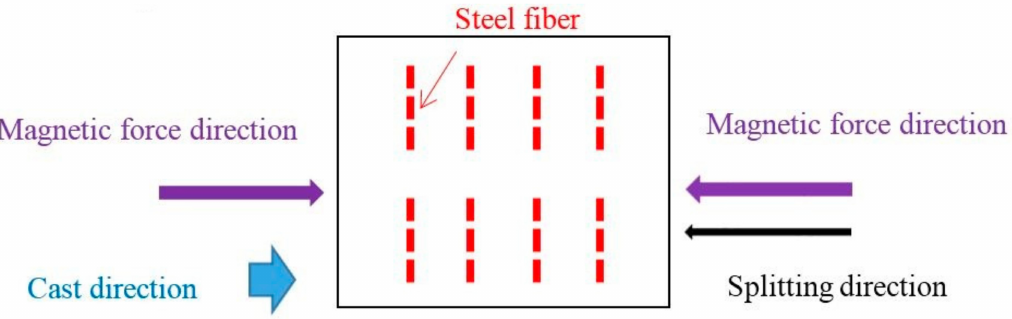
Figure 1. Test setup of fiber orientation in magnetically driven concrete (MDC).